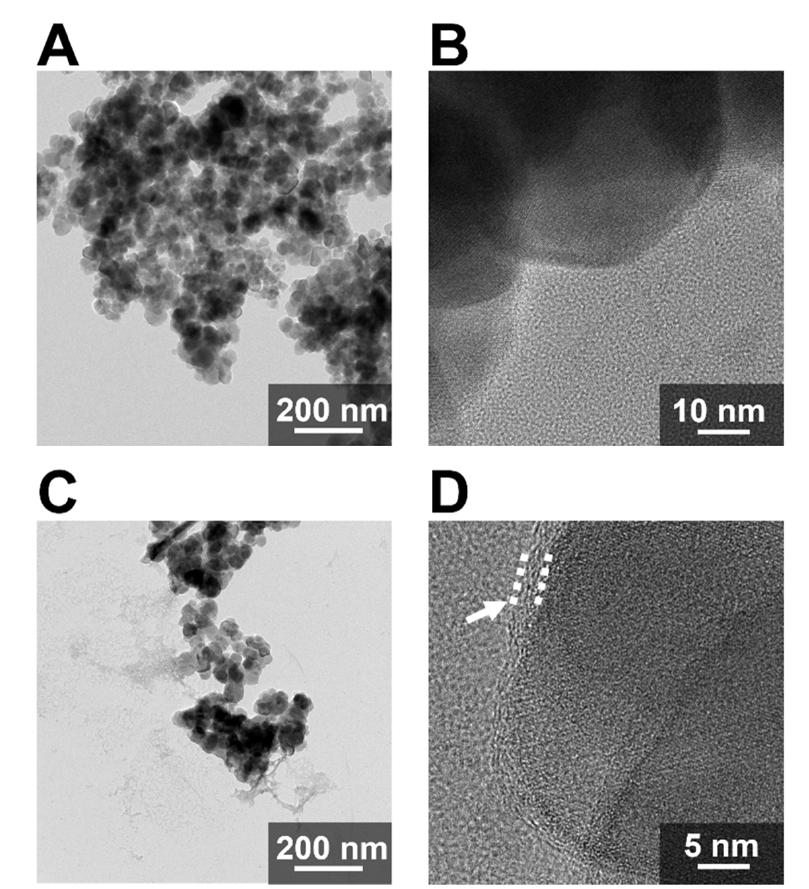
Figure 4. The TEM image of the magnetite nanoparticles in the absence ( A ) or presence ( C ) of the His-Mms6 protein. A single magnetite nanoparticle observed using HR-TEM in the absence ( B ) or presence ( D ) of the His-Mms6 protein. The white arrow indicates the protein corona.